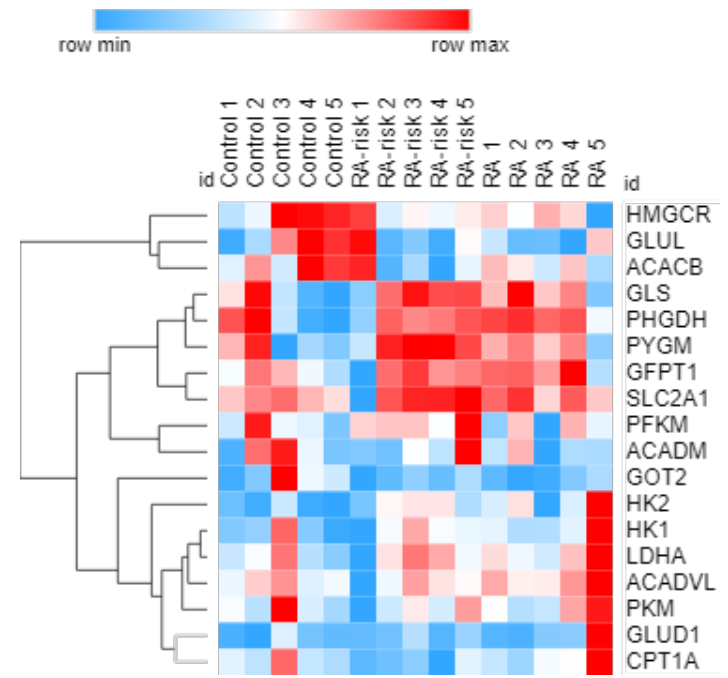
Figure 6. Gene expression analysis of metabolic pathways in LNSCs. Hierarchical cluster diagram visualizing the relative expression levels of 18 genes involved in glucose, fatty acid and glutamine metabolism measured using real-time qPCR. Hierarchical clustering was performed using average linking clustering of the rows (genes) only, with metric one-minus spearman rank correlation for non-parametric data. The cluster diagram was created using Morpheus (https://software.broadinstitute.org/morpheus, accessed on 2 September 2022).